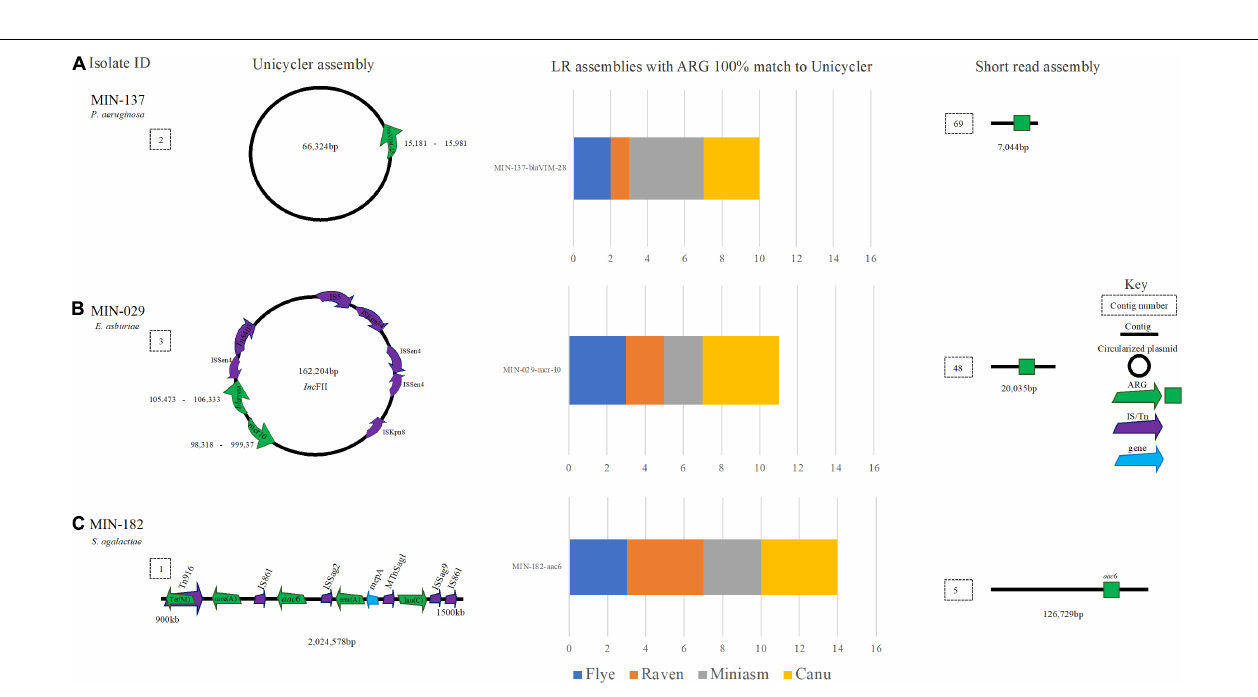
Frontiers in Microbiology |